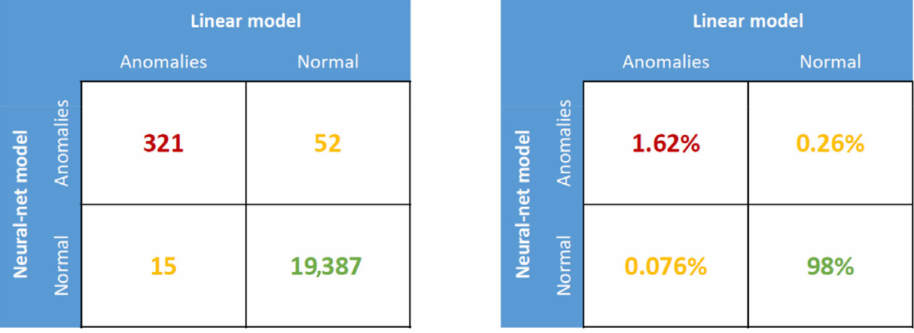
Figure 11. Comparison between the linear-regression and neural-network